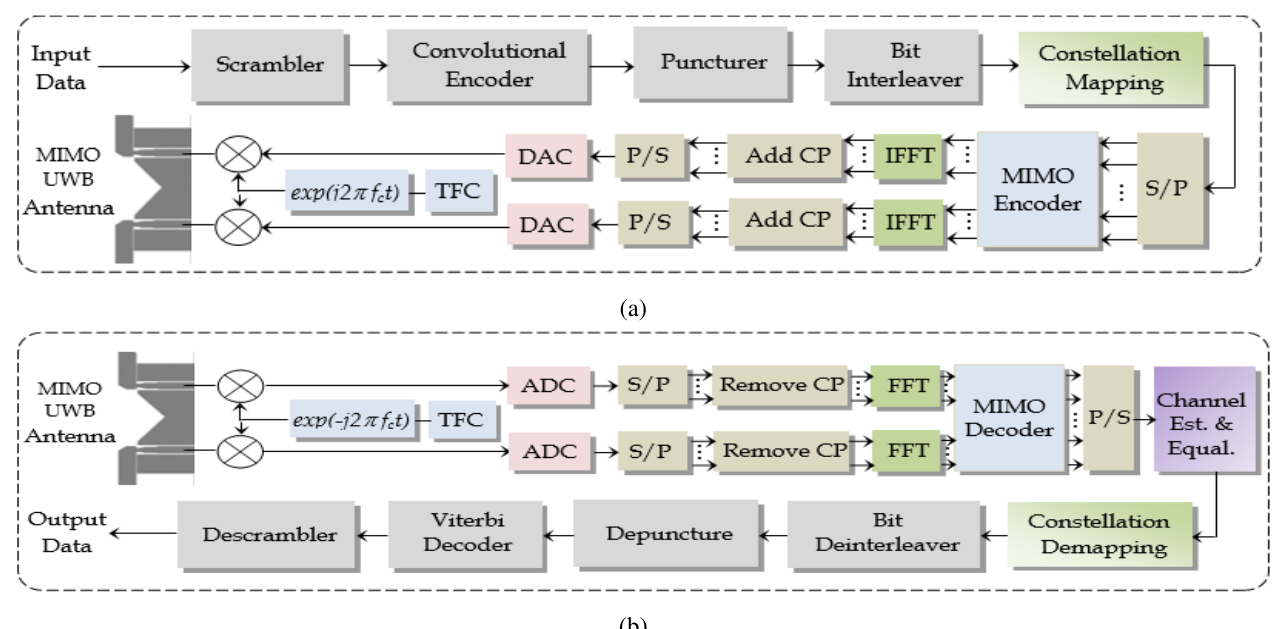
FIGURE 1: The MIMO ECMA-368 MB-OFDM communication system with the proposed MIMO UWB antenna (a) The transmitter (b) The